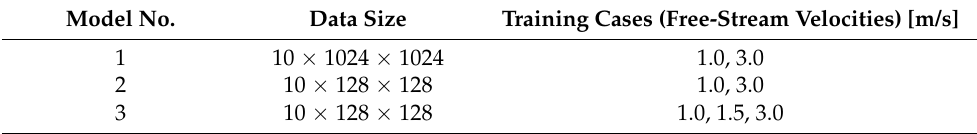
Table 8. Data dimensions and training cases applied in each CNN model. Model No. Model